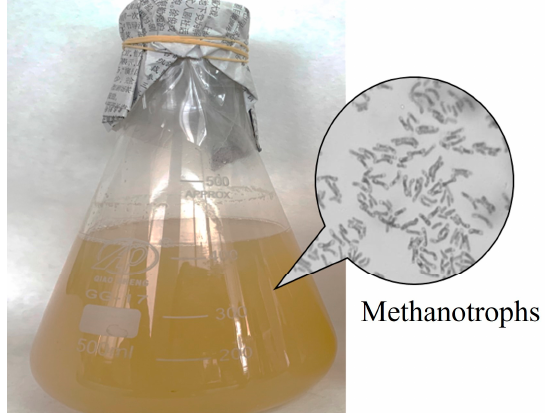
Figure 3. Methanotroph solution and morphology.